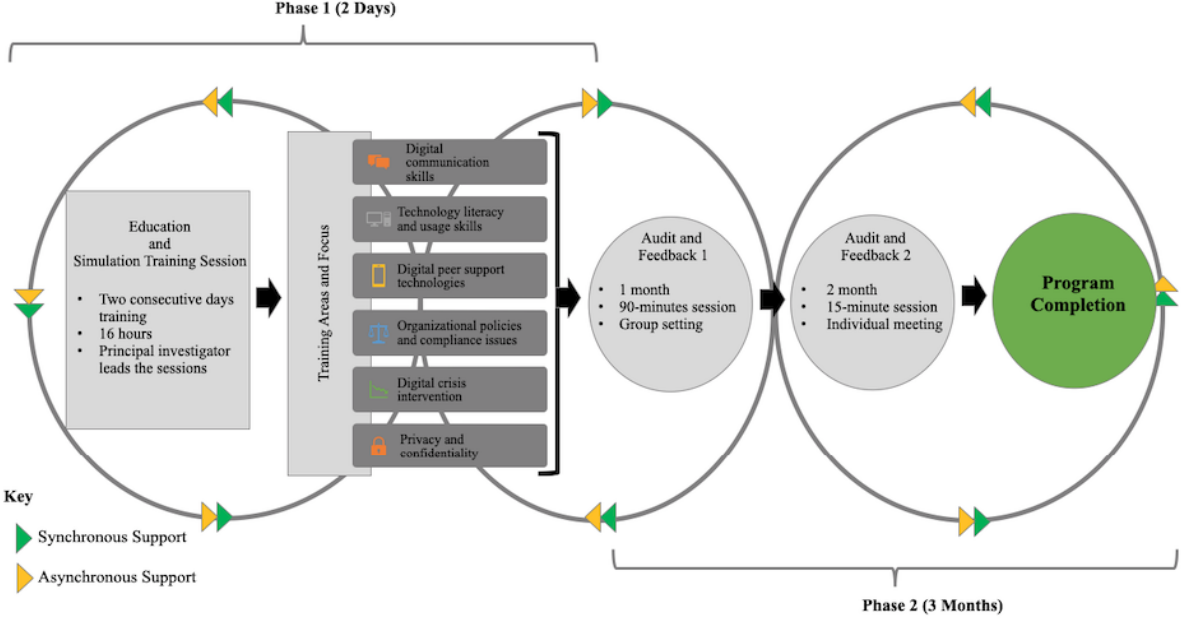
Figure 1. Digital Peer Support Certification